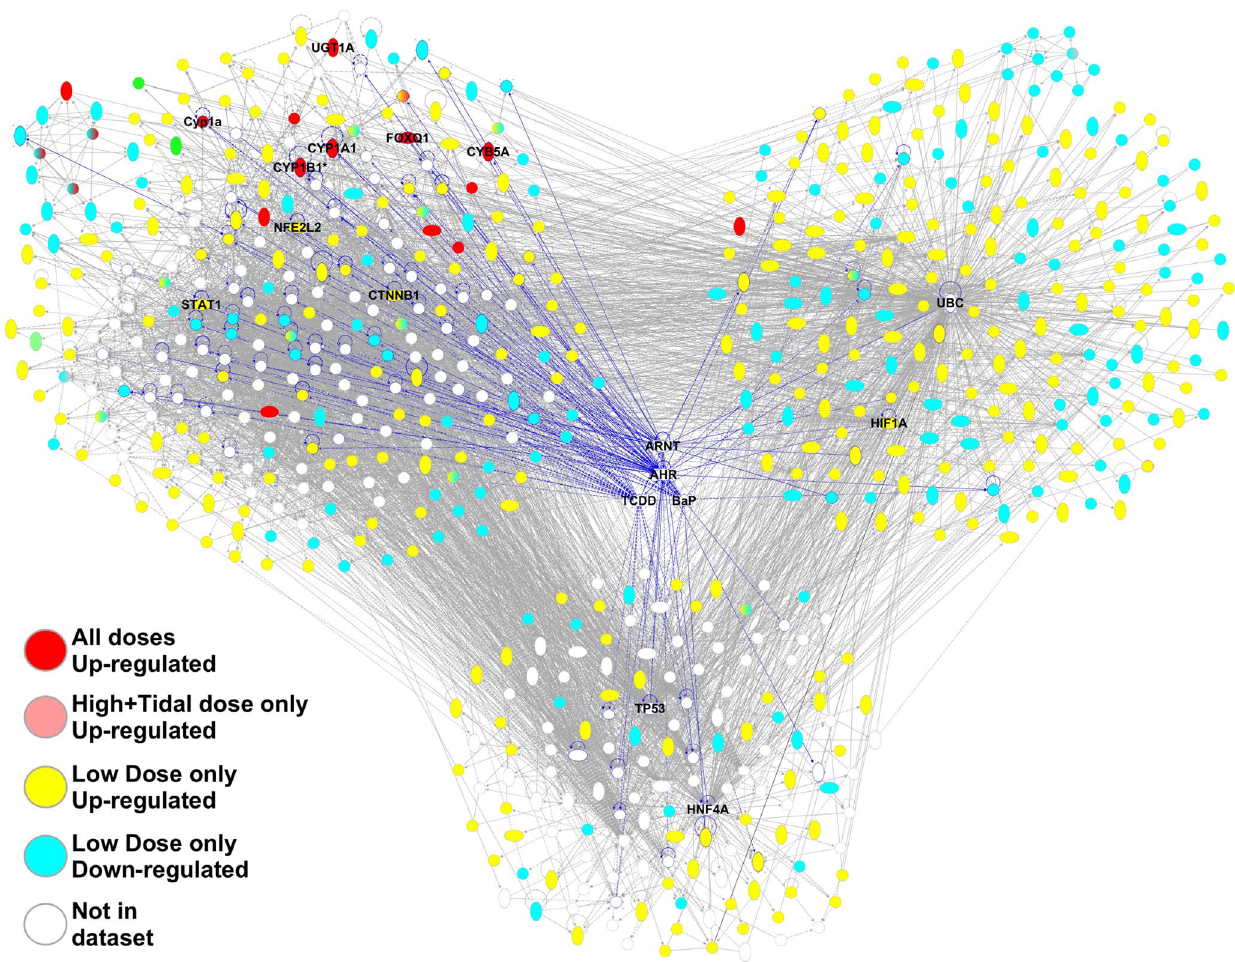
Figure 4. Gill gene interaction network connected by aryl hydrocarbon receptor (AHR) and aryl hydrocarbon receptor nuclear translocator (ARNT) hubs and model toxicants benzo-a-pyrene (BaP) and 2,3,7,8-tetrachlorodibenzo- p -dioxin (TCDD). Genes up- regulated at high concentrations (Fig. 2 cluster 1) are colored red, genes that are up- and down-regulated in the low concentration only are colored yellow and blue, respectively. Lines represent interactions between genes, and blue lines highlight genes that directly interact with AHR/ARNT/TCDD/ BAP. The same figure, but including names for all genes, is supplied as Figure S2 in File S1.